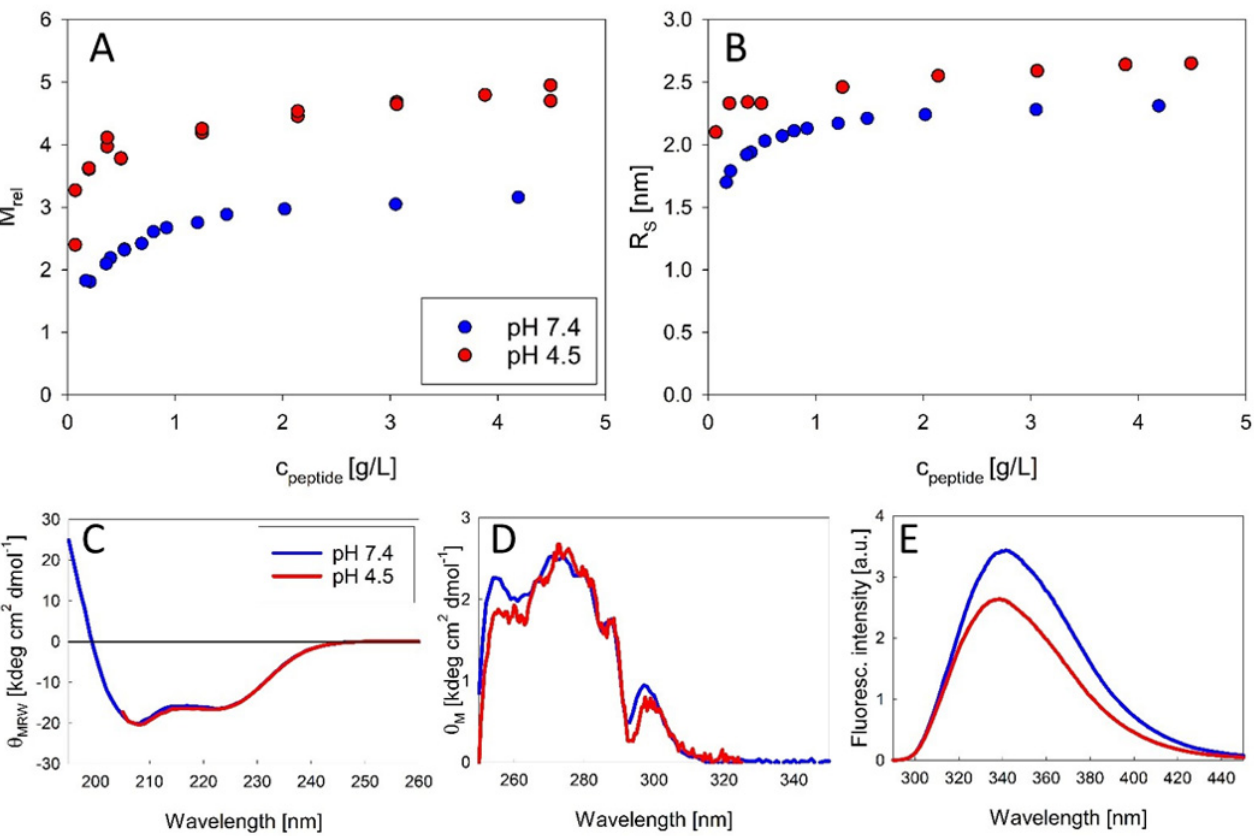
Figure 2. Structural parameters of exendin-4 at pH 7.4 and pH 4.5. ( A , B ) show association equilibria in the context of relative molecular masses M rel ( A ) and Stokes radii R S ( B ) measured at 23 °C. Far-UV CD ( C ), near-UV CD ( D ) and Trp fluorescence ( E ) spectra were measured at peptide concentrations > 0.1 mM, indicative of exendin-4 in the oligomeric state and fluorescence intensity is shown normalized to peptide concentration. Light scattering data for exendin-4 at pH 7.4 have been published previously [4].